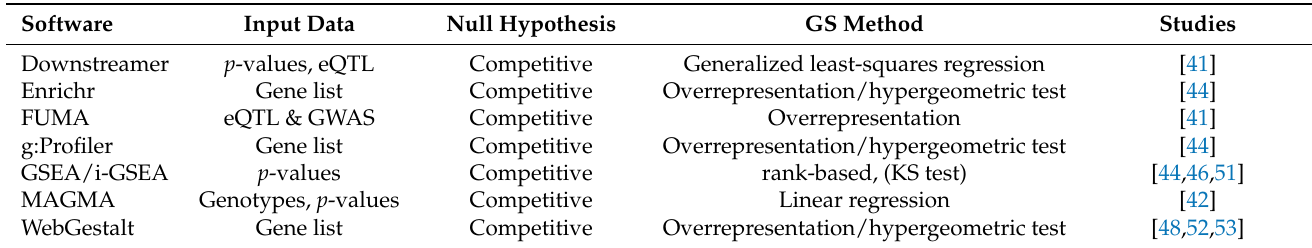
Table 2. Current gene-set analysis (GSA) software employed by the collected ALS GWAS-GSA studies. Each GSA software is characterised by the type of input data, the null hypothesis (self- contained/competitive), and the gene-set method, employed by each study. eQTL: expression Quantitative Trait Loci, GS: gene set, GSA: Gene-Set Analysis, GWAS: Genome-Wide Association Studies, KS: